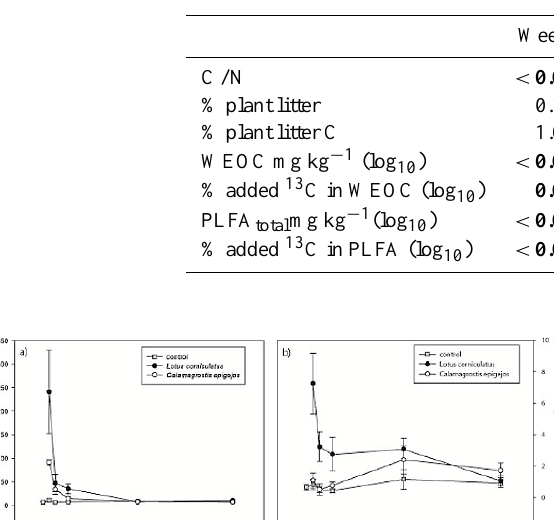
Table 2. Adjusted p values for the plant species effect as revealed with a 2-way ANOVA for each time point (Figs. 2 and 3). Significant differences are indicated by bold numbers ( p ≤ 0 . 05).